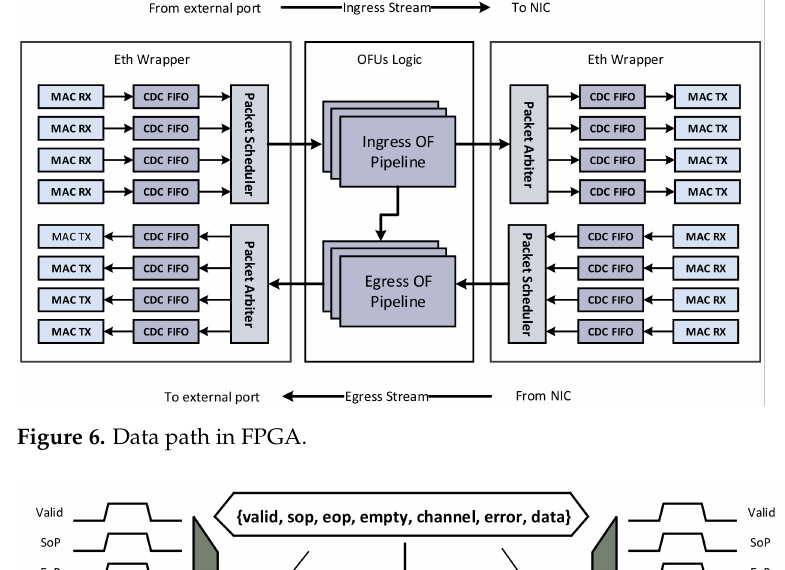
Figure 6. Data path in FPGA.